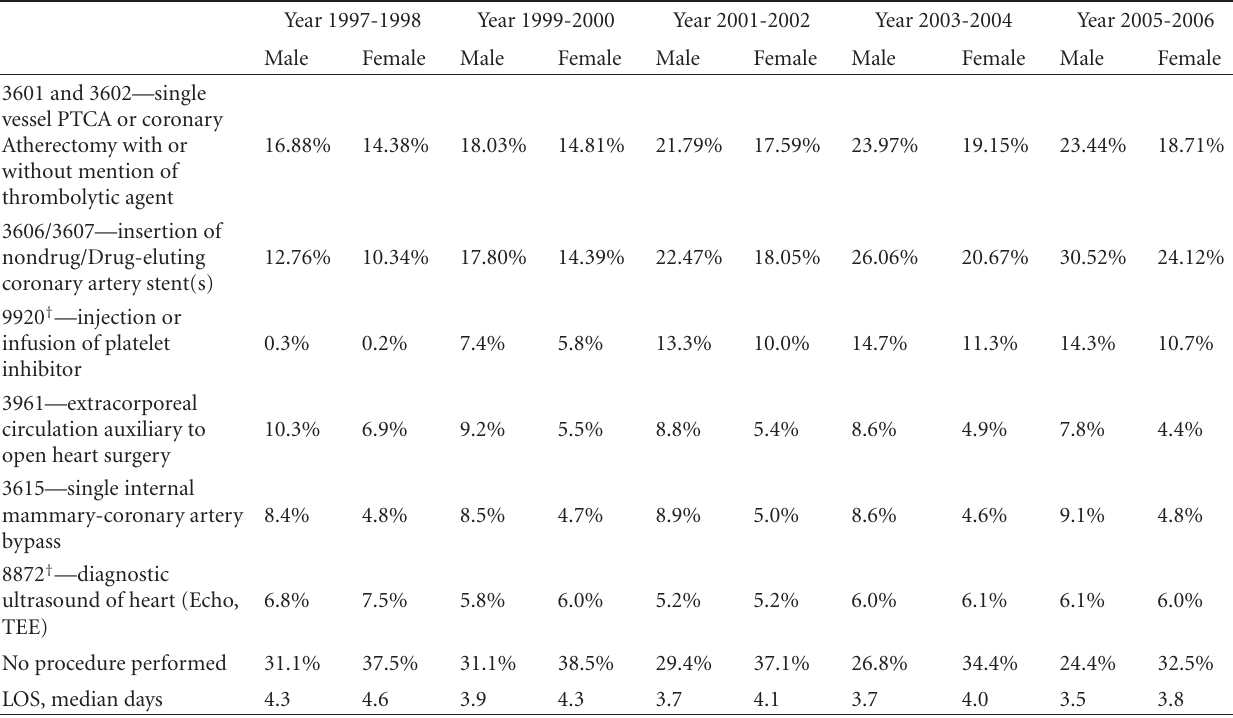
marked di ff erence observed among females age < 55